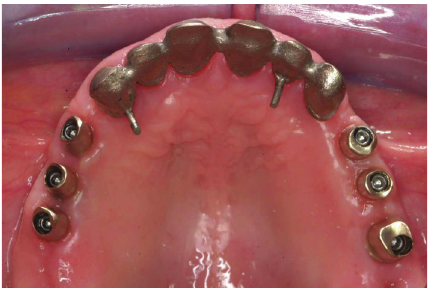
Figure 35: The final restoration included a tooth-borne fixed partial denture from teeth 13 to 23 and two implant-supported fixed partial dentures, one from implant 16 to 14 and the other from implant 24 to 26.